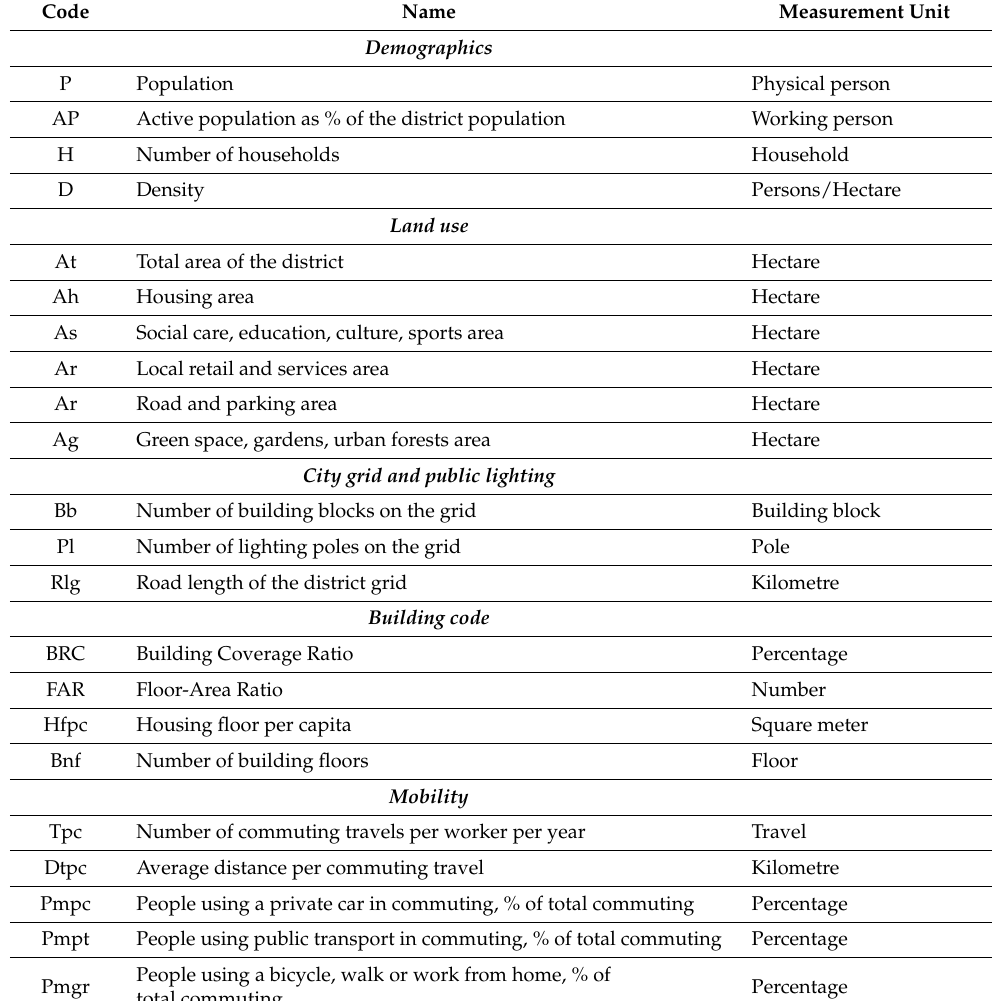
Table 2. Key variables and metrics of housing district spatial